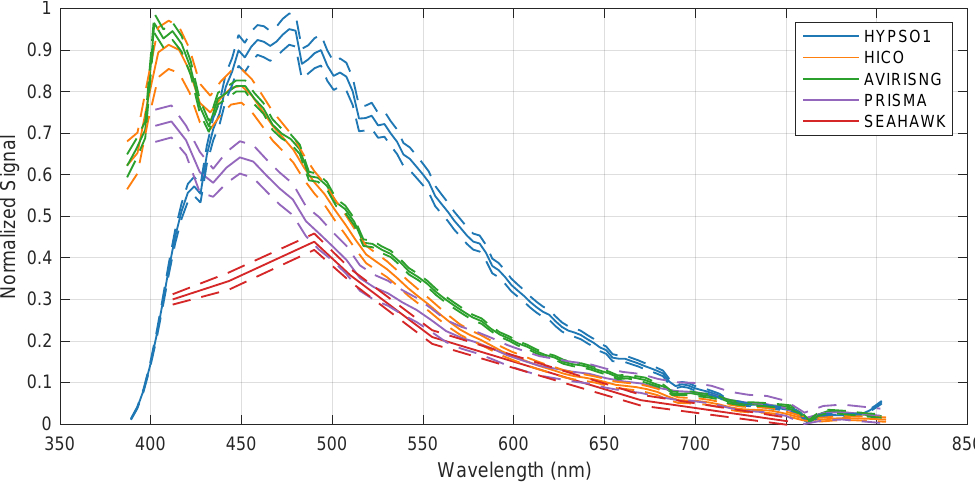
Figure 15. Signal distribution of selected areas in Figure 14 used to assess SNR. Solid lines show mean signal, and dashed lines show two standard deviations from mean signal. All signals are normalized to be between 1 and 0 prior to computing the mean and standard